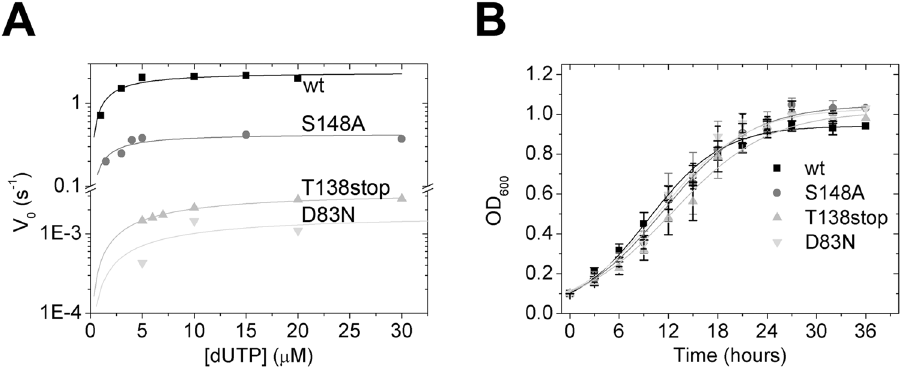
Figure 3. ( A ) Steady-state activity of wt and mutant Duts. Michaelis-Menten curves were measured using the phenol red pH indicator assay. Fitting the Michaelis-Menten equation to the curves yielded the following kcat and KM values: 1.22 ± 0.06 s − 1 and 1.7 ± 0.5 μ M for WT, 0.43 ± 0.04 s − 1 and 1.5 ± 0.6 μ M for S148A, 0.0035 ± 0.0001 s − 1 , 6.7 ± 0.4 μ M for T138stop and 0.0013 ± 0.0005 s − 1 , 7.7 ± 6.7 μ M for D83N mutant Dut. ( B )